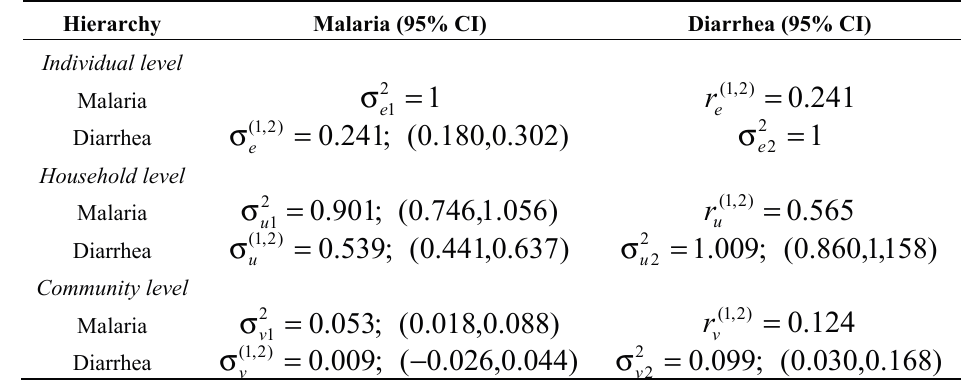
Table 3. Covariance structure from the bivariate model of malaria and diarrhea coexistence in Chikhwawa 2007 §